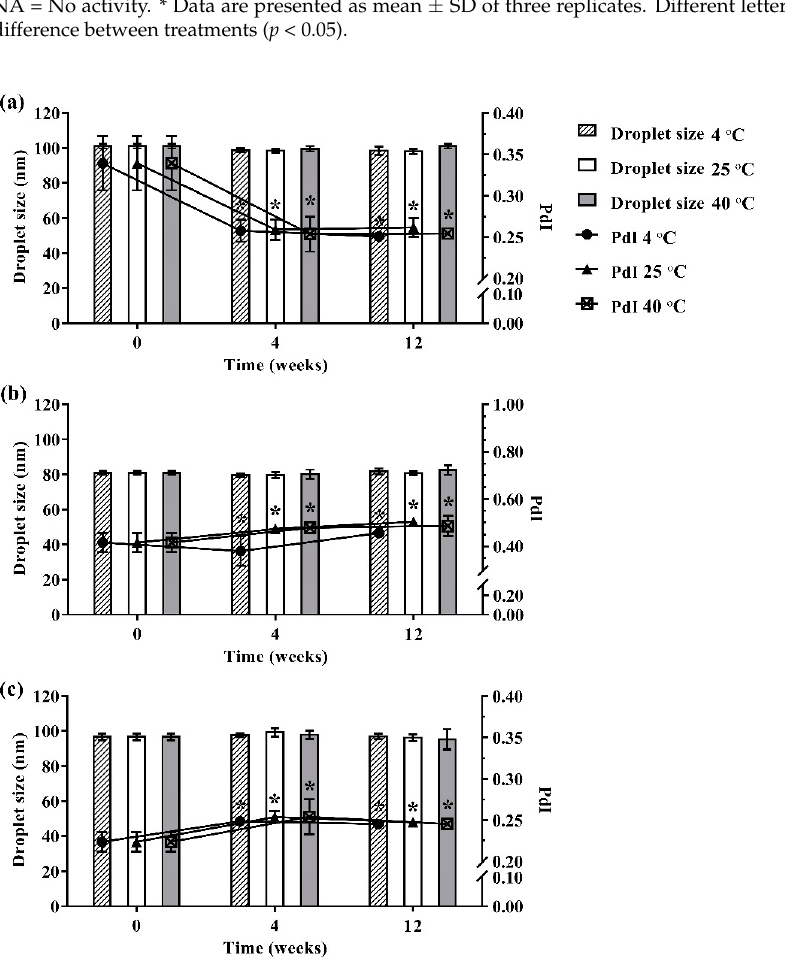
Figure 3. Physical stability of ME-AGO-3 ( a ), ME-C-3 ( b ), and ME-M-3 ( c ). Data are presented as mean ± SD. Asterisks (*) demonstrate the significant difference of droplet size between ME formulations kept at different storage temperatures (4 °C, 25 °C, and 40 °C) and freshly prepared of those formulation ( p < 0.05).